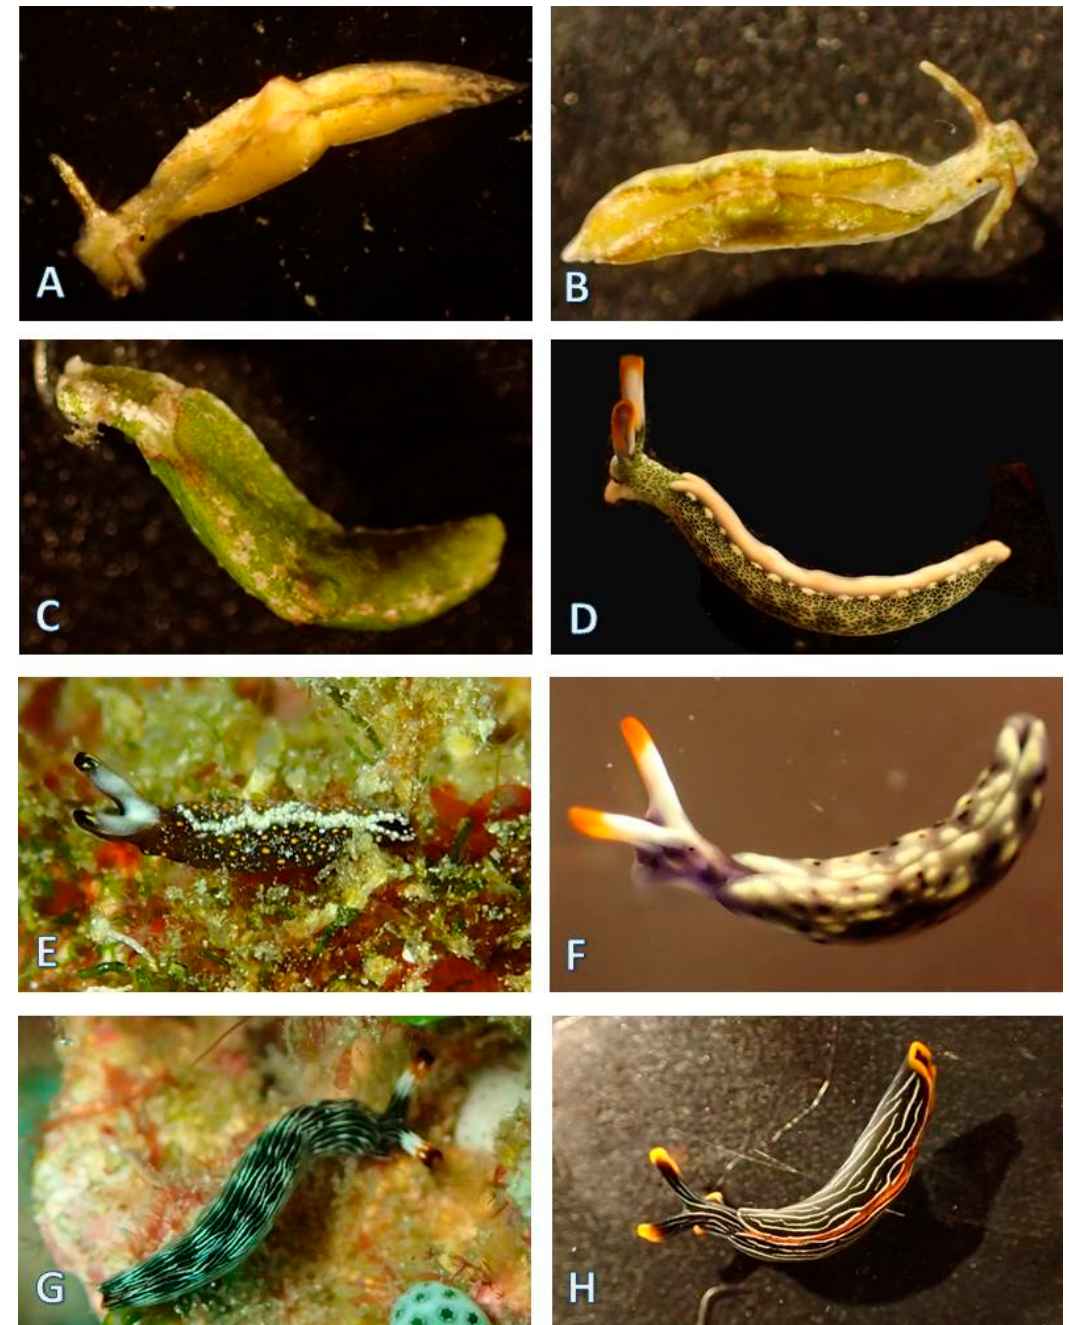
Figure 4. Sacoglossa: ( A ) Elysia sp. ( Elysia sp. 27 in Gosliner et al. [24]: 89), Elsp27-18Ba-1; ( B ) Elysia sp. ( Elysia sp. a), Elsp.a18Ba-1; ( C ) Elysia sp. ( Elysia sp. b), Elsp.b18Ba-1; ( D ) Thuridilla carlsoni, Thca18Ba-1 ; ( E ) Thuridilla flavomaculata, Thfl17Ba-1 ; ( F ) Thuridilla vataae, Thva18Ba-3 ; ( G , H ) Thuridilla gracilis, Thgr18Ba-1, Thgr18Ba-4 .